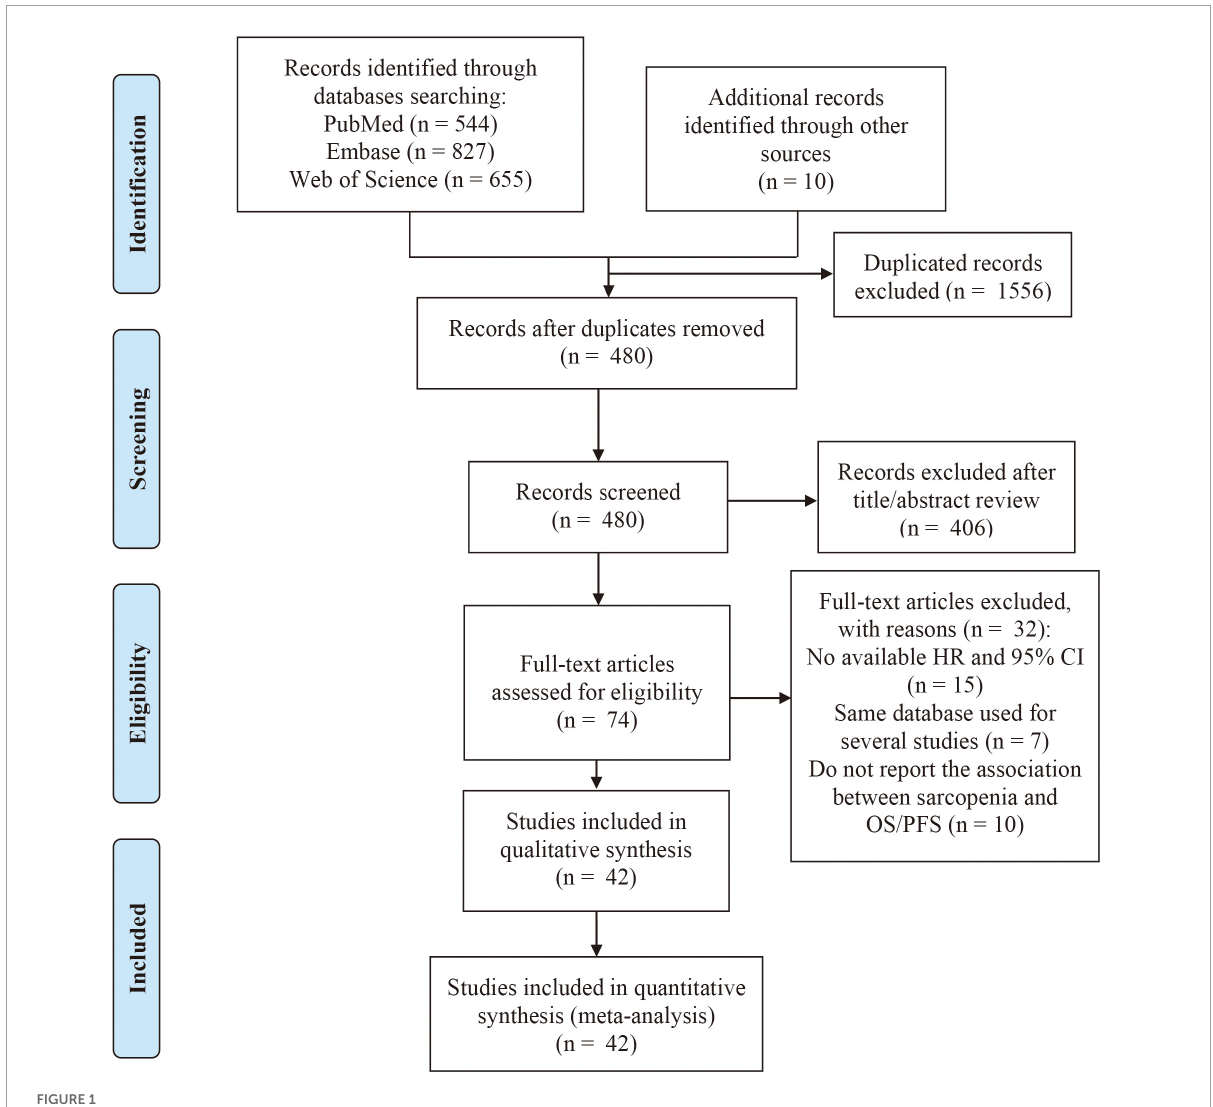
FIGURE1 Flowchart of selecting and screening